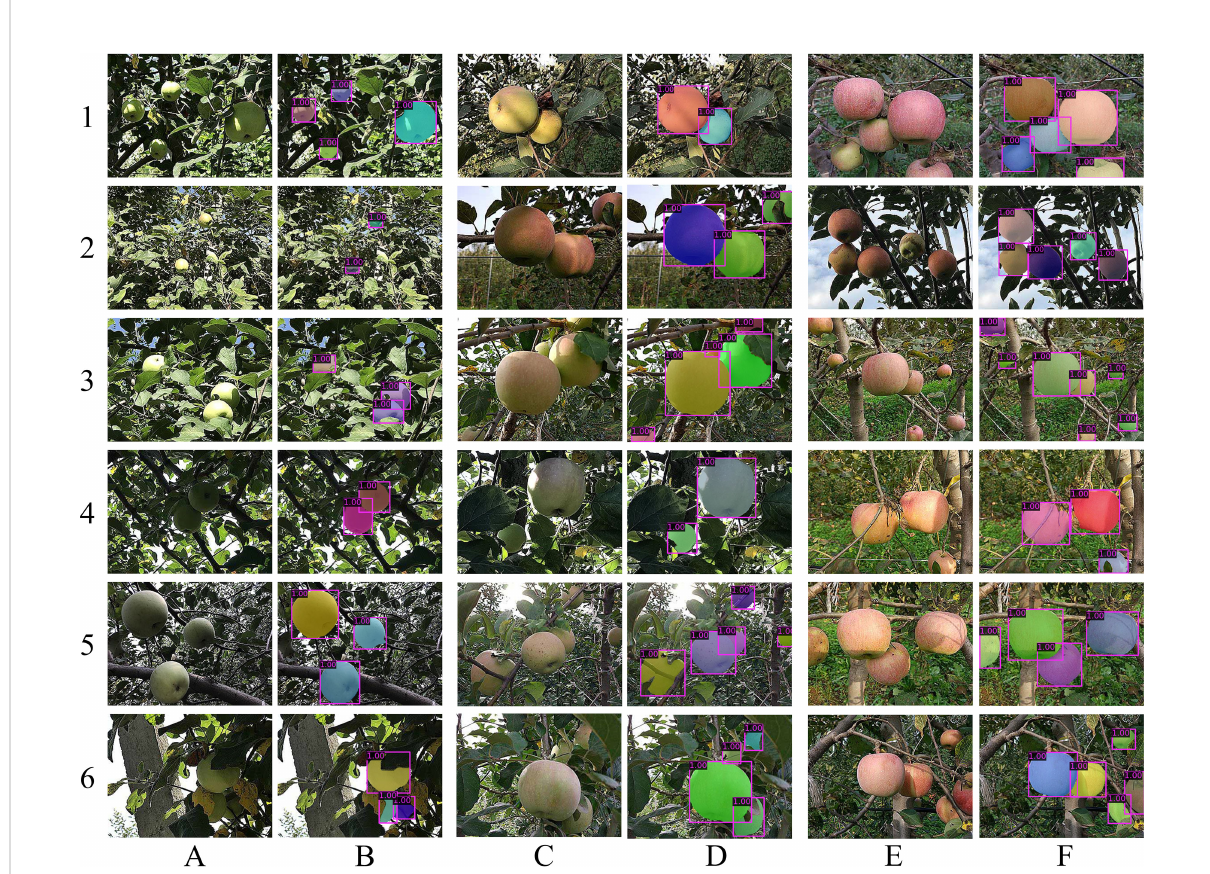
FIGURE 4 Examples of detection and instance segmentation of apples. (A, C, E) Original images. Speci fi cally, (A1) Green apples affected by shadows. (A2) Small green apples with strong illumination on the surface. (A3) Apples affected by overlap, occlusion, shadows, and strong illumination. (A4) Green apple image captured under backlight condition. (A5) Green apples with uneven illuminations on the surface. (A6) Green apples with high similarities to the background. (C1) Overlapped apples with uneven colors. (C2) Apples affected by occlusion, shadows, and uneven colors. (C3) Apples affected by overlap, occlusion, shadows, and uneven colors. (C4) Apples with uneven colors and shadows on the surface captured under backlight conditions. (C5) Apples affected by overlap, occlusion, uneven colors, and backlight. (C6) Apples affected by overlap, occlusion, and uneven colors. (E1) Red overlap apples and apples with uneven colors. (E2) Red apples with uneven illuminations and apples with uneven colors. (E3) Overlapped and small red apples. (E4) Red apples affected by occlusion and shadows. (E5) Red apples affected by overlap and shadows. (E6) Red apples affected by overlap, occlusion, and shadows. (B1-6, D1-6, F1-6) Detection and instance segmentation results of images in (A, C, E) .